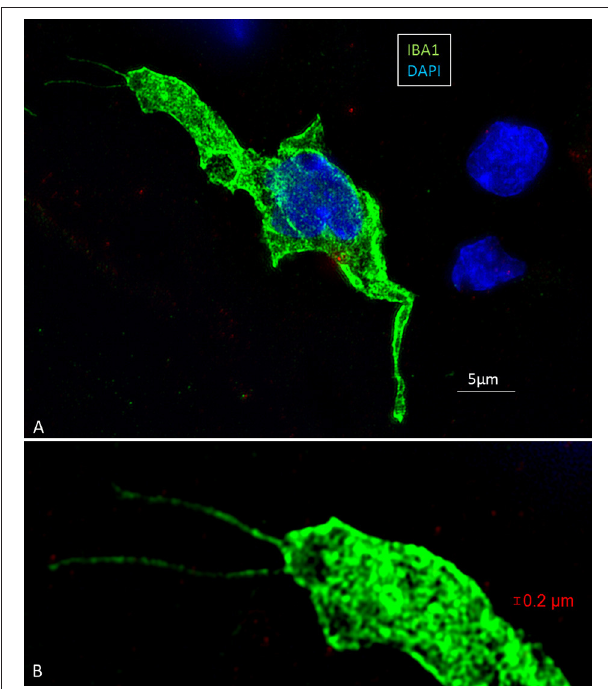
FIGURE 6 | (A) SR-SIM of an amoeboid human macrophage located in the human cochlea. (B) The cell is endowed with long processes or “antennae” which are apparently involved in the scanning of the microenvironment. The IBA1 protein (green) fills the entire cells and is also typically located in the nucleoplasm (DAPI). Note the presence of large intracytoplasmic vesicles. From Frontiers in Immunology 2018 ( 10).